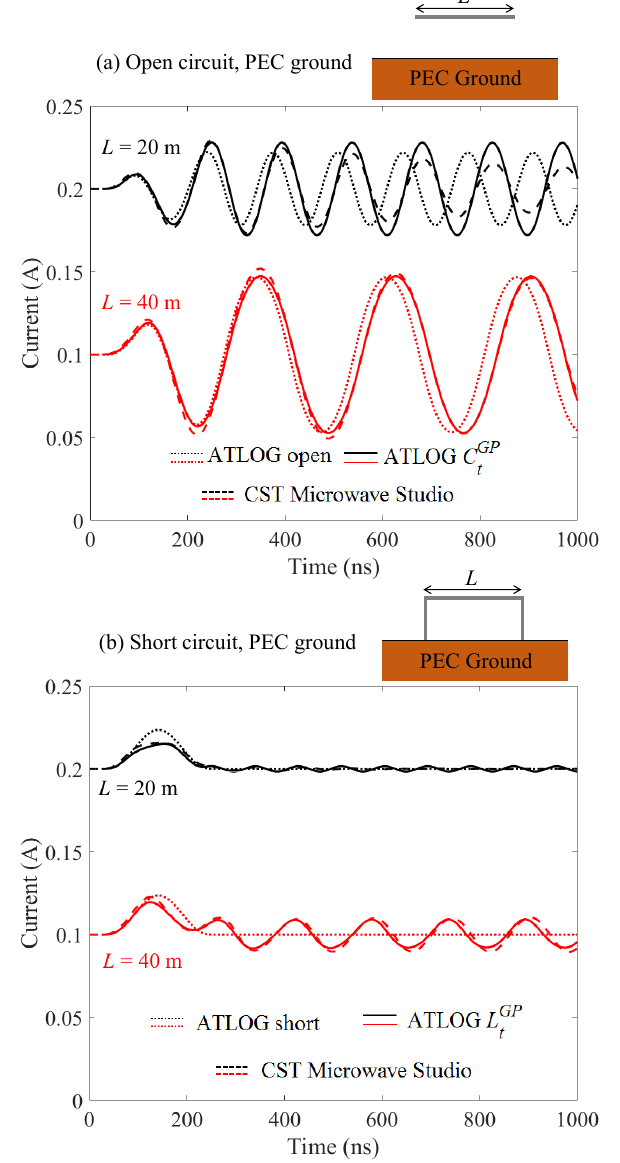
Figure 2: Comparison of full wave simulations (dashed curves) using CST Microwave Studio with transmission line having (a) idealized open circuits at each end (dotted curves) and terminating capacitors at each end (solid curves) and (b) idealized short circuits at each end (dotted curves) and terminating inductances at each end (solid curves). The line lengths are given on the left end of the graph, and an inset shows a schematic of the simulated geometry. Note that an arbitrary shift of +0.1 A has been added to the 40 m length result, and an arbitrary shift of +0.2 A has been added to the 20 m curve, to separate the different lengths and make the different curves